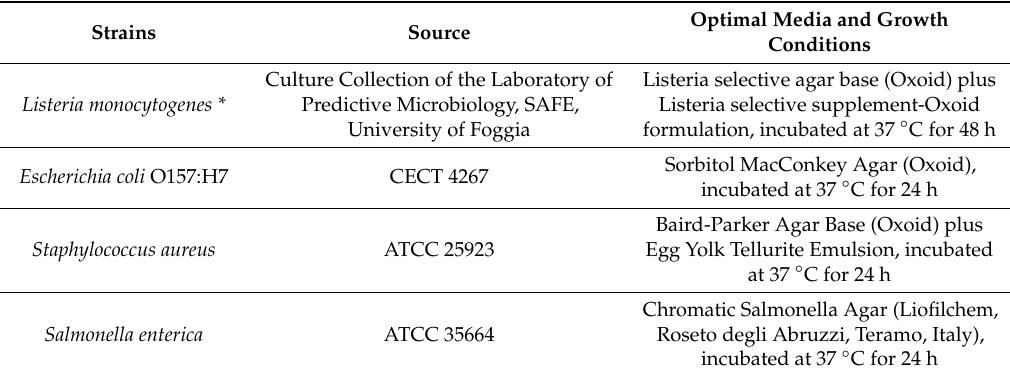
Table 1. Pathogen strains used in the study with the indication of their source and optimal media and growth conditions